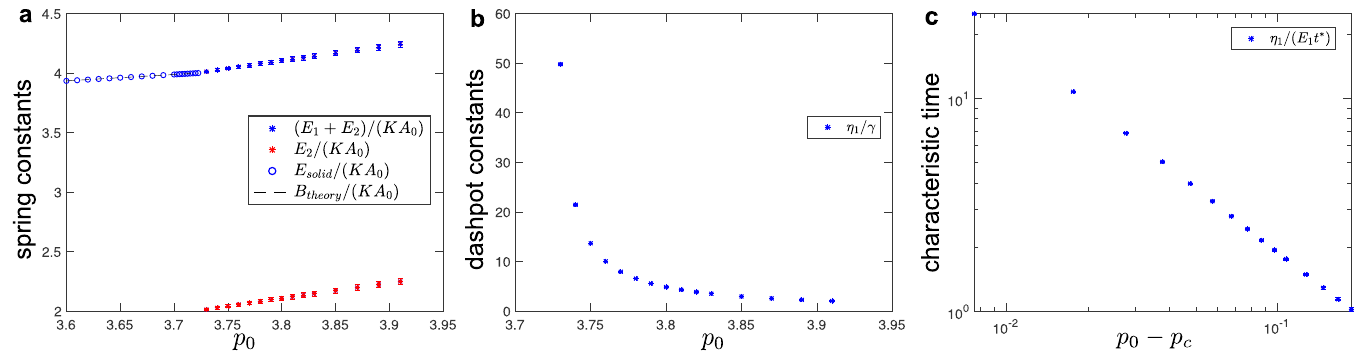
Fig 7. Fitted values of spring-dashpot models for the system under bulk deformation as a function of the target cell-shape parameter, p 0 . (a) Elastic constants as a function of the target cell-shape parameter, p 0 . In the solid phase ( p 0 < p c � 3.722), the bulk storage modulus E solid agrees with the analytical prediction B theory in Eq (9) (dashed line). At the solid-fluid transition point ( p 0 = p � 3.722), it continuously changes to the high frequency limit of the bulk storage modulus, i.e., B 0 ( ω 0 ! 1 ) = E 1 c + E 2 , of the fluid phase. The low frequency limit of the bulk storage modulus is B 0 ( ω 0 ! 0) = E 2 in the fluid phase. (b) Dashpot viscosity constant as a function of the target cell-shape parameter, p 0 . (c) Characteristic timescales in the fluid phase obtained from the fitted values of the elastic constant and the dashpot viscosity. The normalization factor t � = γ /( KA 0 ) sets the unit of time. For the fluid phase ( p 0 > p c � 3.722), errorbars correspond to the standard deviation for simulations that were repeated for configurations that correspond to different local energy